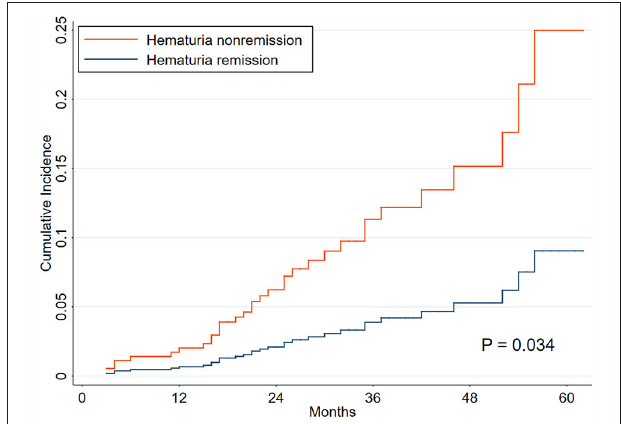
FIGURE 4 | Cumulative incidence curves for composite renal progression events grouped by hematuria remission. The cumulative incidence function methods and Gray test were used for analyses. The time zero was kidney biopsy. The endpoint was renal progression, defined as a 40% decline in renal function or end-stage renal disease. Death without renal progression was treated as a competing